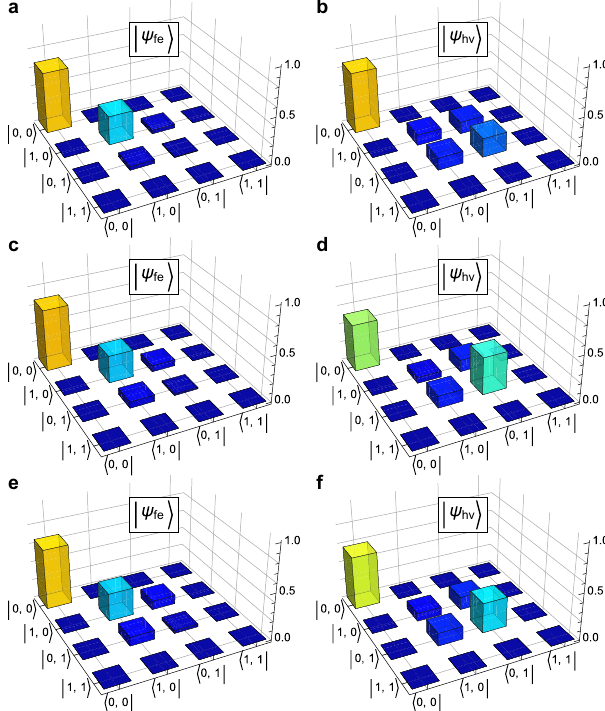
Fig. 4 Absolute values of the density matrix elements for quantum states distributed via different types of channels. a Maximally-mode-entangled state sent through an uncorrected quantum channel with L = 0.988 ± 0.001 added loss. b Same input state, but distributed through the error-corrected quantum channel with the nominal gain setting from Fig. 3, at which the observed concurrence was the highest. c , d and e , f same as a , b , but with L = 0.958 ± 0.001 and L = 0.903 ± 0.002,